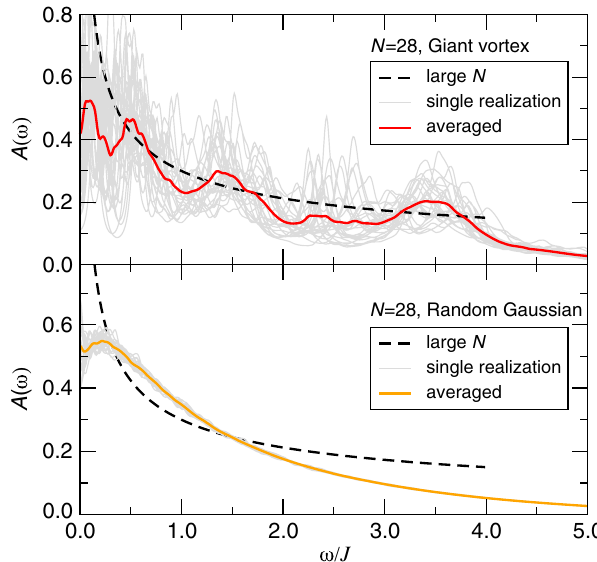
FIG. 7. Spectral function A ð ω Þ computed at zero temperature for coupling constants J obtained from the giant vortex ijkl calculation (top) and taken from the Gaussian distribution (bottom). Thin gray lines represent individual disorder realiza- tions corresponding to a physical measurement in a system with quenched disorder. Thick lines reflect the average over 25 independent disorder realizations. Dashed lines represent the expected low-frequency behavior in the large- N conformal limit Eq. (3.7). All parameters are as in Fig. 4 with J ¼ 1 , K ¼ 0 and broadening δ ¼ 0 . 04 in Eq.